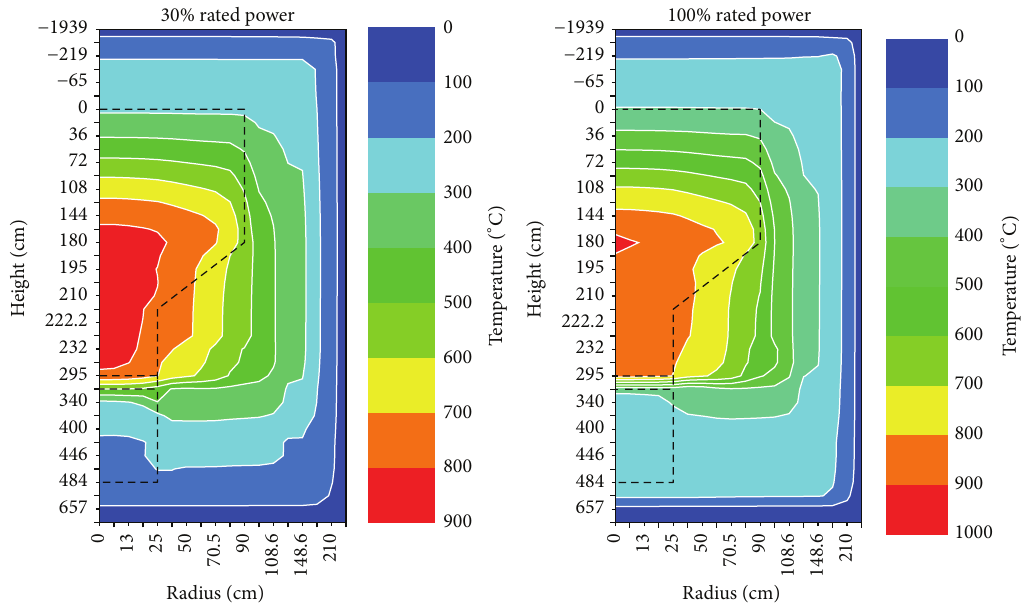
Figure 10: Temperature fields at different power